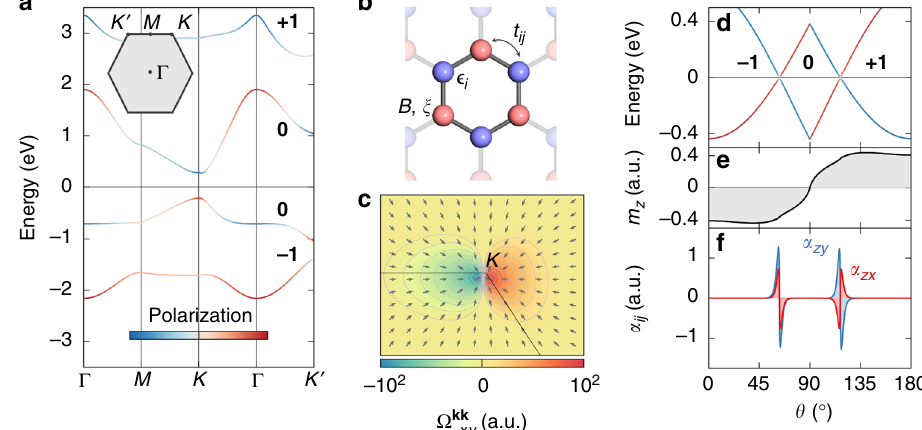
Fig. 2 Model of a mixed topological semimetal. a Band structure for θ = 45°, showing the lowest four energy bands of the p -model on the buckled honeycomb lattice. Bold numbers refer to the individual Chern numbers of the bands, and colors encode the states ’ polarization in terms of p x − ip y (blue) and p x + ip y (red) orbital character. b Honeycomb lattice of the model. ( c ) Distribution of the Berry curvature Ω kk xy in momentum space close to the emergent nodal point for θ = 60°. The in-plane direction of the full Berry curvature fi eld Ω is indicated by unit arrows that refer to the mixed curvatures (cid:3) Ω b mk Ω b mk – f Evolution with respect to the magnetization direction θ of d the valence band top and conduction band bottom, e the total orbital yy and yx . d magnetization m z , and f the orbital Edelstein response α ij using k B T = 25 meV in the Fermi distribution, with the Fermi level set to the energy of the band crossing. In panel d , the Chern number C of the occupied states is bold, and colors denote the orbital polarization as in